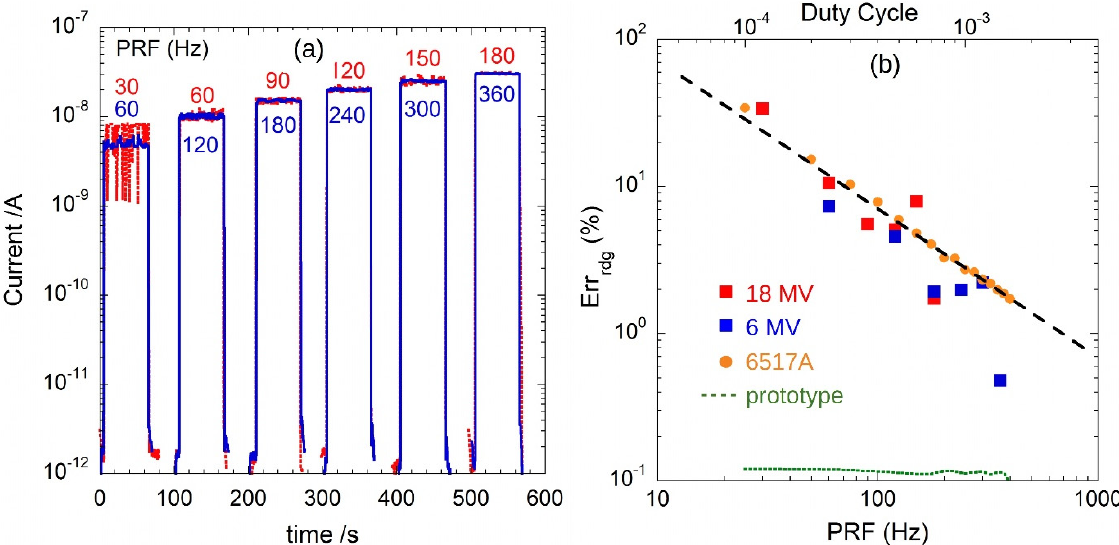
Figure 9. ( a ) Diamond dosimeter photocurrent under pulsed X-ray irradiations at different PRF , i.e., for DR s in the 1–6 Gy/min range. X-ray pulses are sourced by a medical LINAC at 6 MV (blue) and 18 MV (red). Experimental data were acquired by means of a Keithley 6517A electrometer. ( b ) Percentage of the reading error calculated as the ratio between the standard deviation and the mean values of data collected in ( a ) as a function of PRF . Orange dots (6517A electrometer) and green dotted line (proposed GI) refer to lab measurements performed with the Keithely 6221 current source (see text). Dotted line represents the expected ( T INT × PRF ) − 1 behavior.